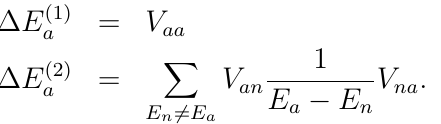
Figure 1: Basic self-energy Feynman